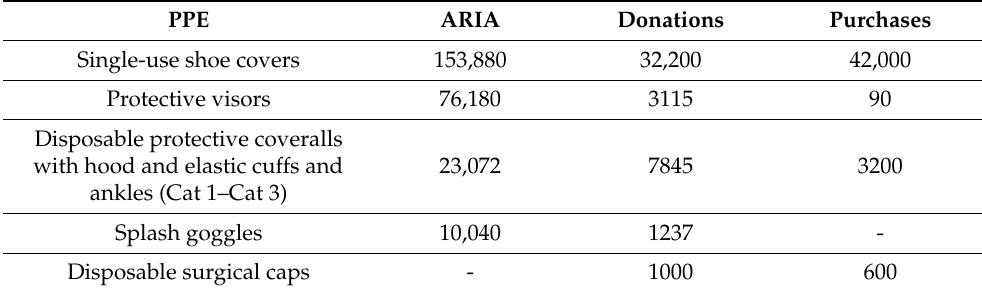
Table 12. PPE delivered to the Spedali Civili Hospital in Brescia from 28 February 2020 to 31 May